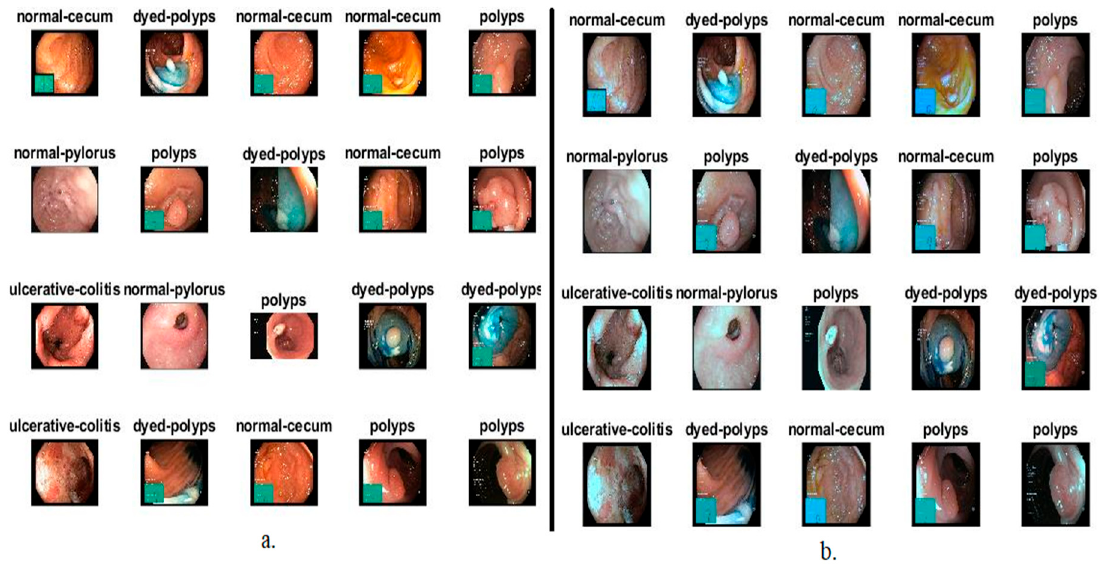
Figure 2. Images of the dataset for all types of diseases ( a ) Before enhancement ( b ) After enhance- ment.